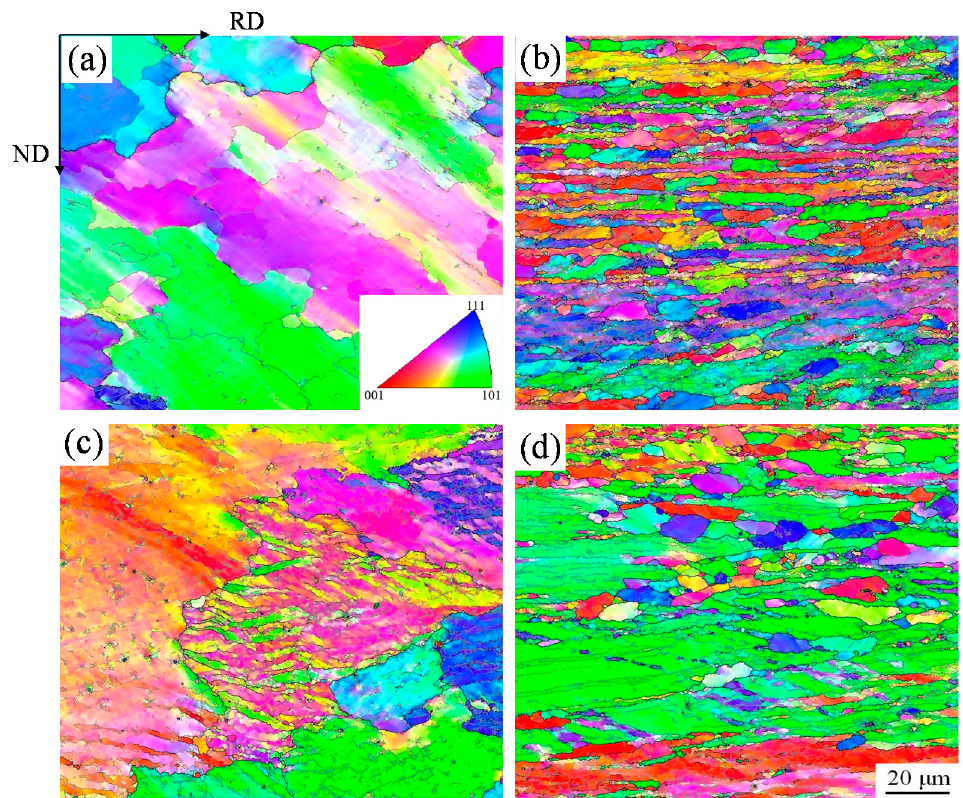
Figure 4. EBSD IPF maps of annealed 1561 aluminum alloys at different deformation stages in the central region. ( a ) the H1 plate; ( b ) the H2 plate; ( c ) the N1 plate ; ( d ) the N2 plate.